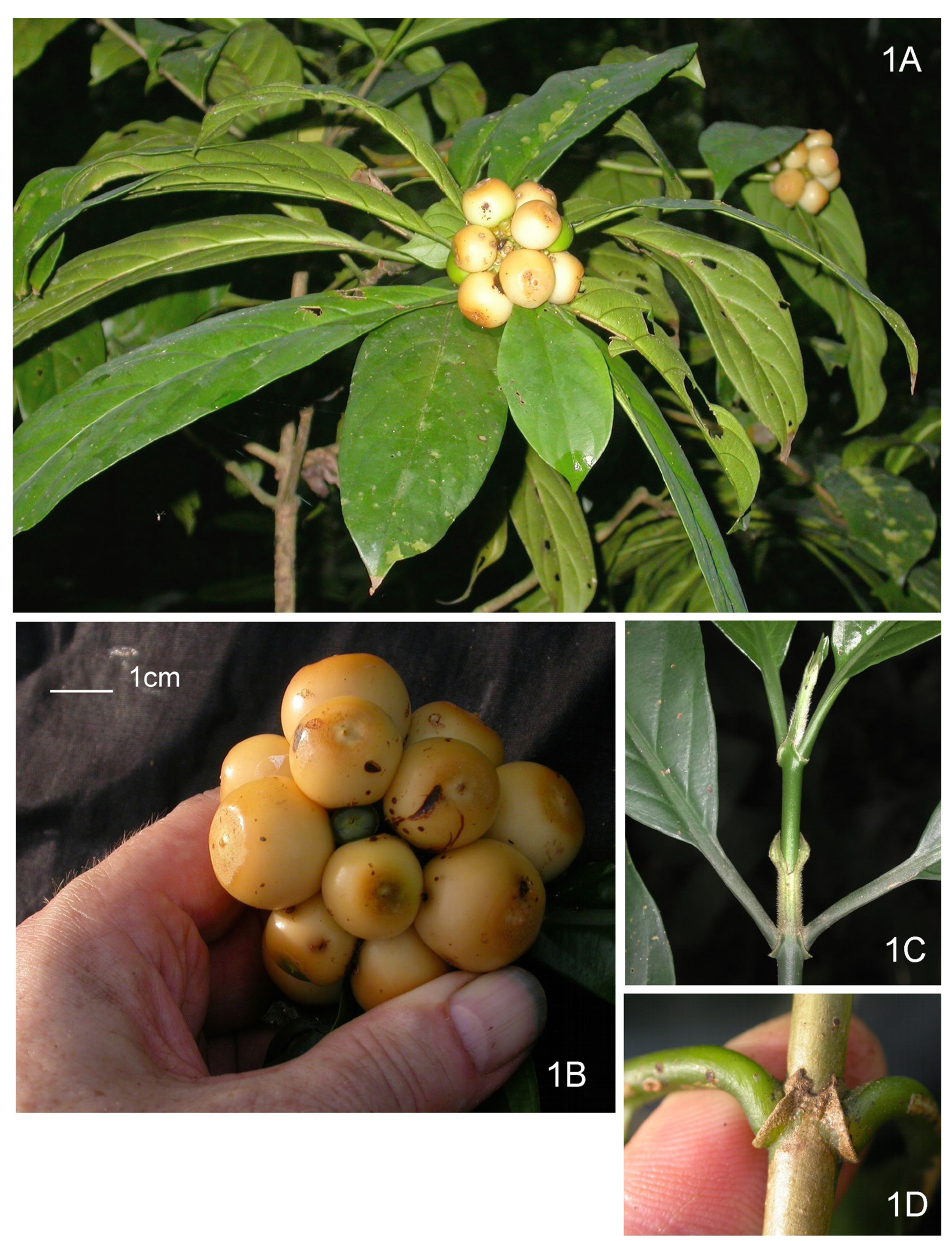
Fig. 1. Gaertnera luteocarpa sp. nov. subsp. luteocarpa . A . Habit in fruit. B . Fruits. C . Stipules. D . Twig showing ridges around base of petiole. A, B & D from Hawthorne & Gyakari 205a063 ; C from Hawthorne & Gyakari 201a223 . Photos W.D.